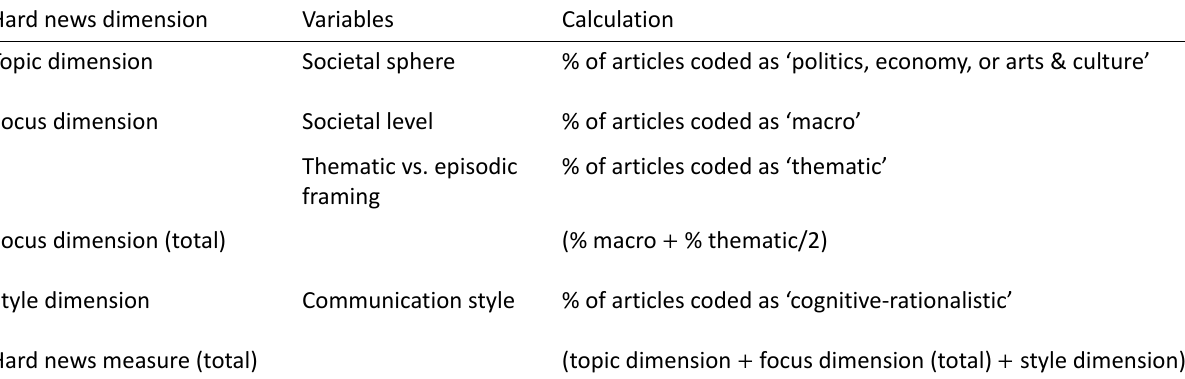
Table 2. Operationalization of hard news.